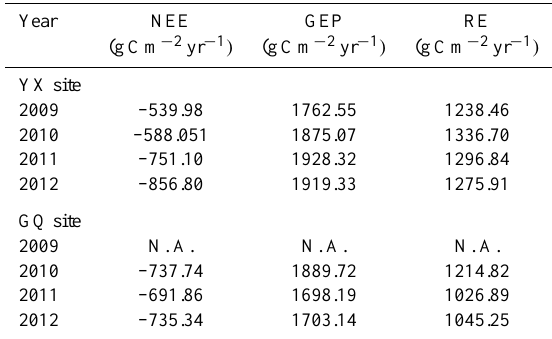
Table 4. Mean annual net ecosystem CO 2 exchange (NEE), gross ecosystem production (GEP), ecosystem respiration (RE) for Yunx- iao (YX) and Gaoqiao (GQ) during 2009 and